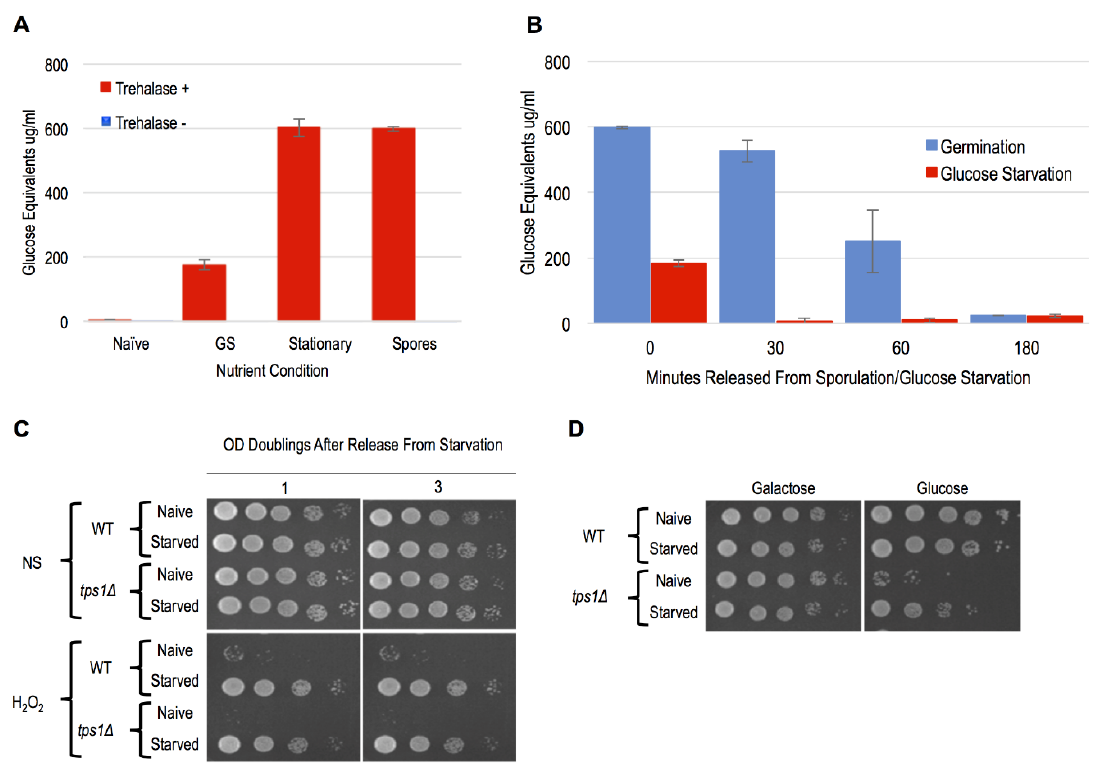
FIGURE 5: Neither trehalose accumulation nor TPS1 activity accounted for cellular memory. (A) The indicated cells were extracted and assayed for trehalose levels using an enzymatic assay. Error bars represent 1 standard error of the mean from 3 biological replicates. (B) These same cells were diluted into YPD media and trehalose levels of the resulting cultured cells were determined at the indicated timepoints. Error bars represent 1 standard error of the mean from 3 biological replicates (C) H 2 O 2 stress resistance spot assay of 12 hours galactose starvation (Starved) and mid-log cells (Naive) of WT and tps1 Δ are shown. NS represents cells that were not stressed with peroxide. (D) 10-fold serial dilution spot assay of WT and tps1 Δ on either SC-Galactose plates (Galactose) or SC-Glucose (Glucose)